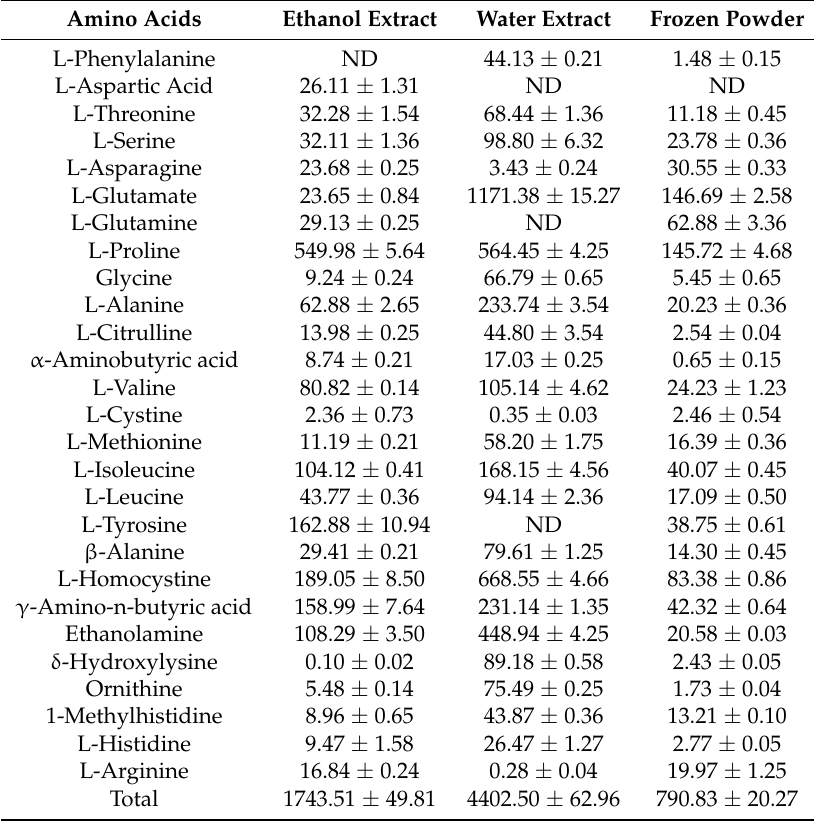
Table 1. Contents of free amino acids in spinach extracts (mg/100